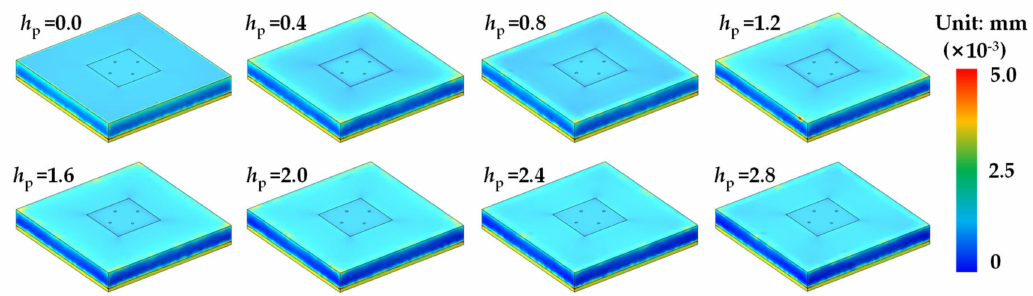
Figure 11. Surface strain of the MEMS pressure chip at different h p at 150 ◦